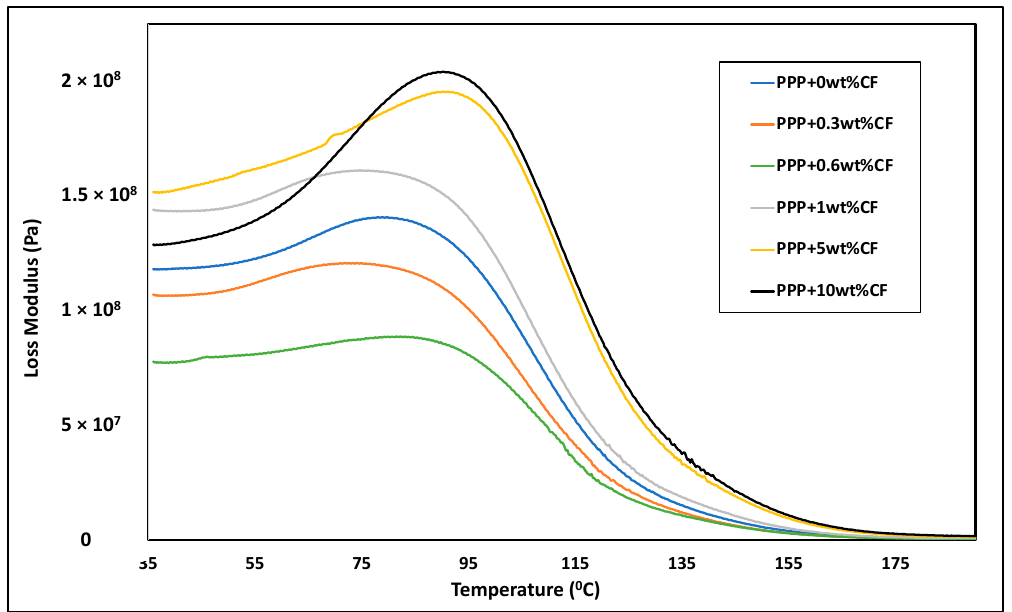
Figure 7. DMA test result of PPP/CF composites; e ff ect of CF content in SLS-Printed fully cured thermose tt ing samples on storage modulus.